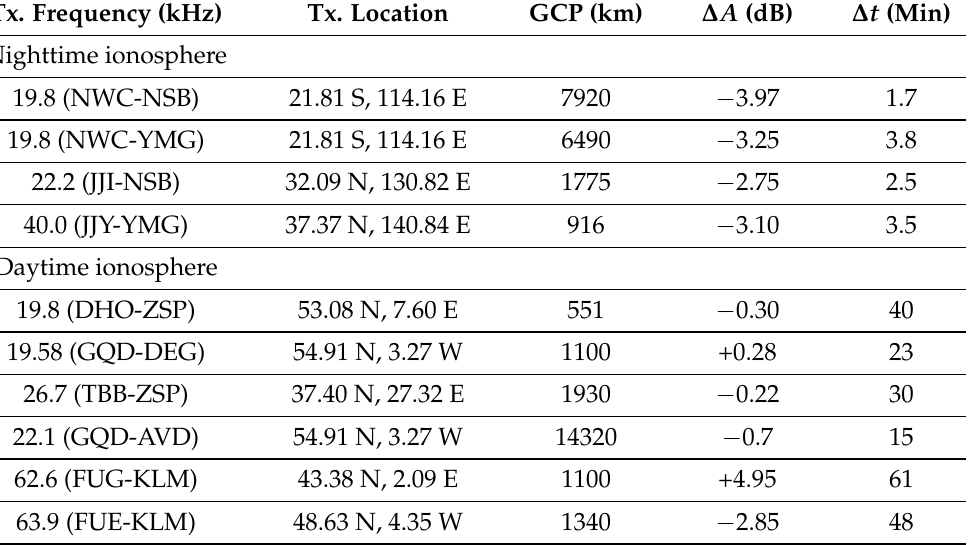
Figure 4. ( a ) Daytime LF radio signals perturbations associated with the GRB221009A received at KLM, Germany. Here, the signal recovery times are higher for both frequencies compared to the VLF signals. ( b ) Zoomed version of ( a ) to show the effect of the 2nd burst at 48,065 s. Table 1. Summary of all VLF/LF